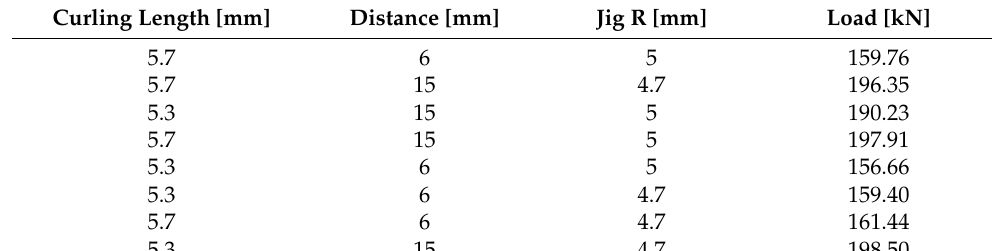
Figure 9. Comparison of correlation between design variables. Table 3. Dataset for sensitivity analysis. Table 3. Dataset for sensitivity analysis.